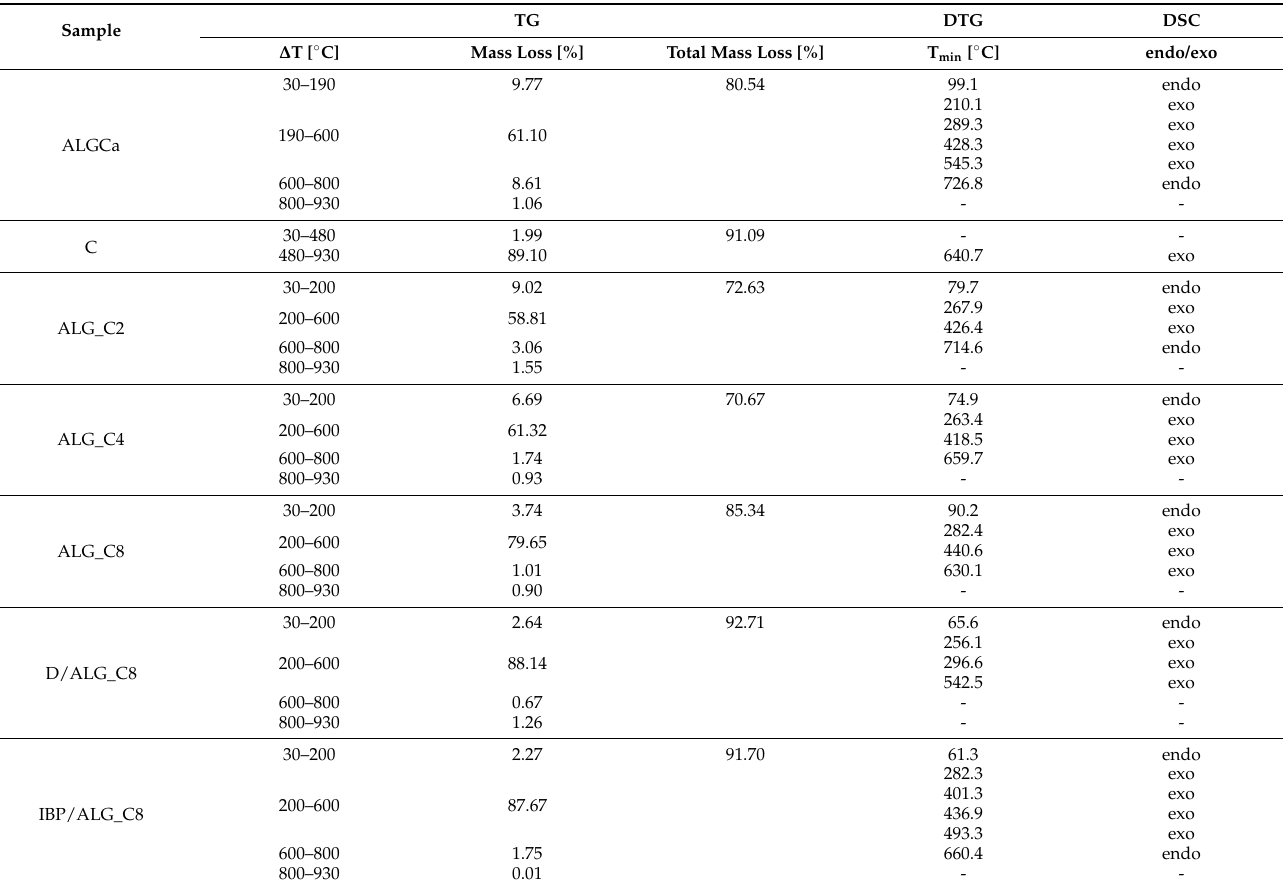
Table 6. The thermal decomposition data of pure ALGCa, ALG_C2, ALG_C8, and C material as well as samples after ibuprofen and diclofenac adsorption on